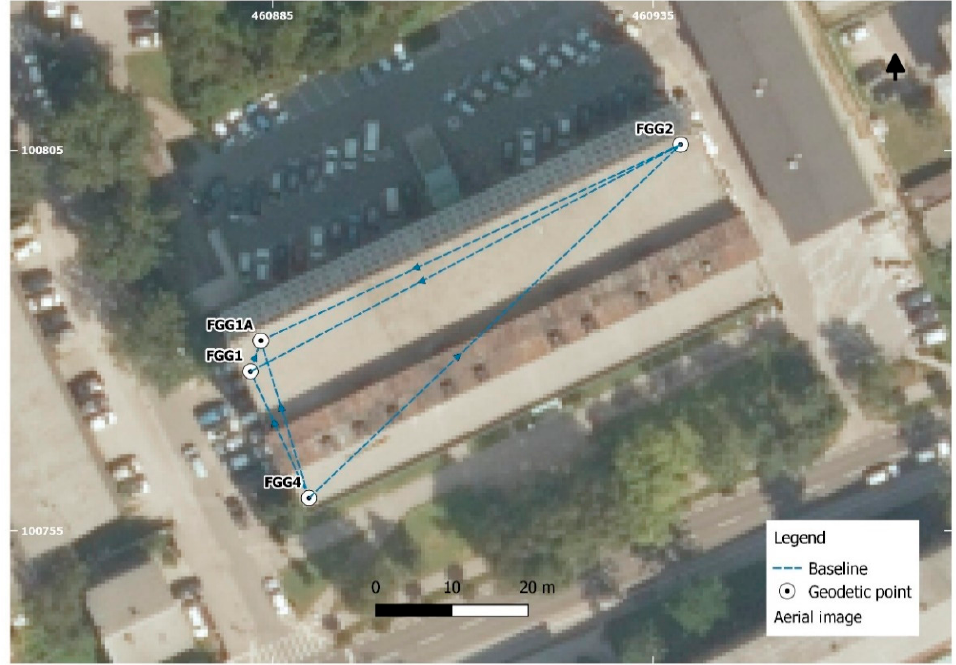
Figure 5. The geodetic network.